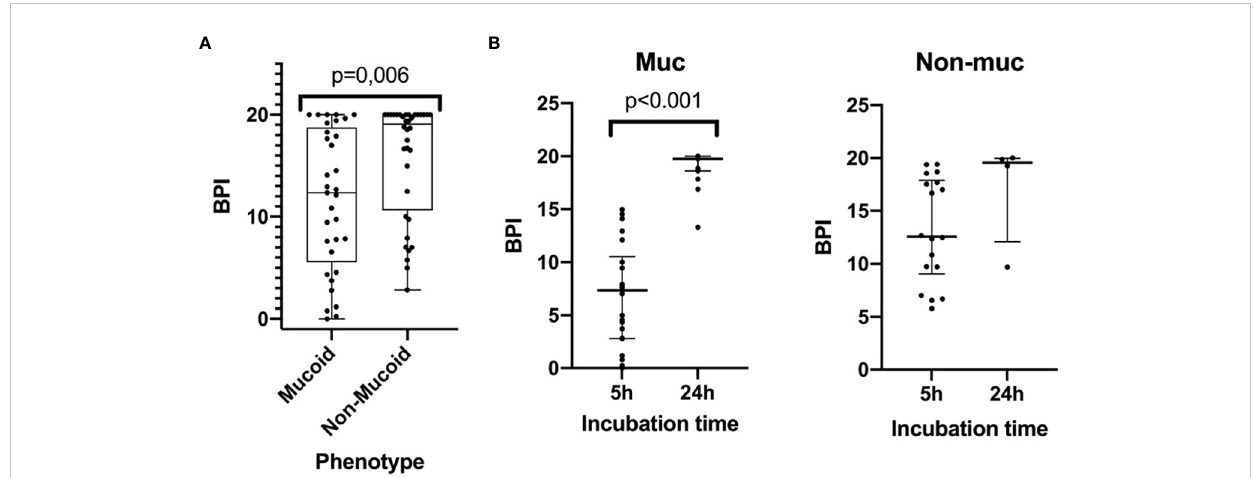
FIGURE 2 The Bio fi lm index of mucoid and non-mucoid PA phenotypes and its time-dependent increase during incubation. (A) Boxplot showing BPI of the 69 PA isolates, by mucoid and non-mucoid PA, read at 5h as recommended by manufacturer. Median and interquartile ratio are represented by the box and whiskers show the maximum and minimum values. The non-mucoid vs mucoid PA phenotype is associated with an increased BPI (19,08 [10,63- 20,00] vs 12,36 [5,55-18,74] p=0.006, respectively). (B) BPI at 5 vs 24h by phenotype. Median is represented by the central line whilst interquartile ratio is represented by the two lines at the extremes. A statistically signi fi cant increase of the BPI can be seen in mucoid strains when incubating at 24 h whilst a greater heterogenous non-statistically signi fi cant result is achieved in non-mucoid